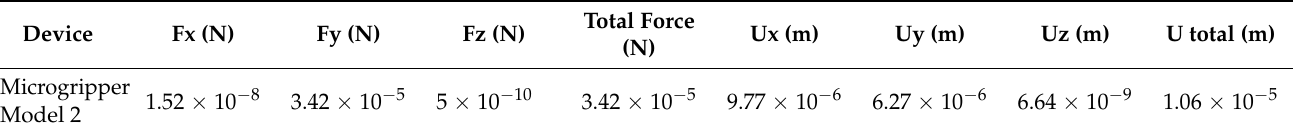
Table 8. Parameters values for microgripper Model 2 at 2